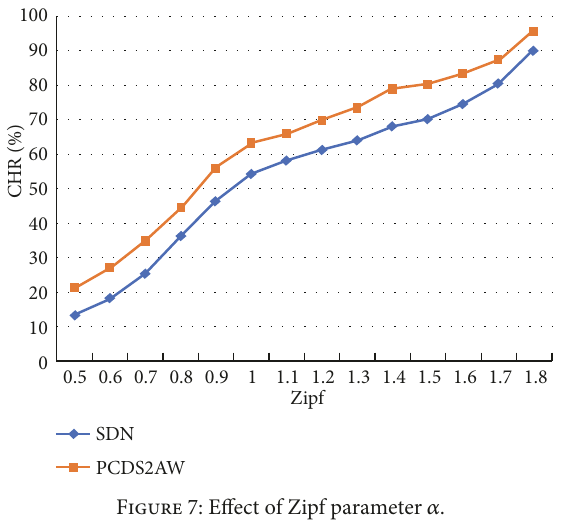
Figure 7: Effect of Zipf parameter 𝛼 .